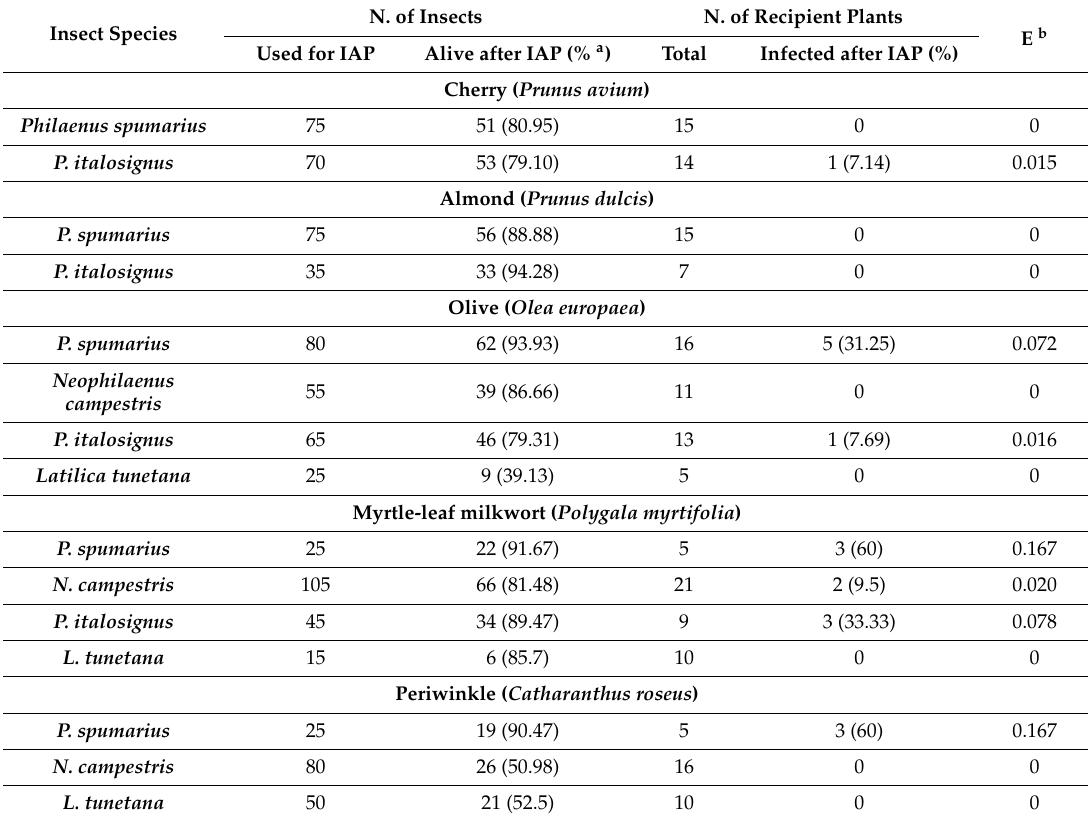
Table 2. Data collected from the six transmission experiments carried out in 2017 using specimens of di ff erent insect species caged for an acquisition access period of 96 h on Xylella fastidiosa infected olive trees. Number of insects and recipient plants of the di ff erent host species used for the inoculation access period (IAP) are